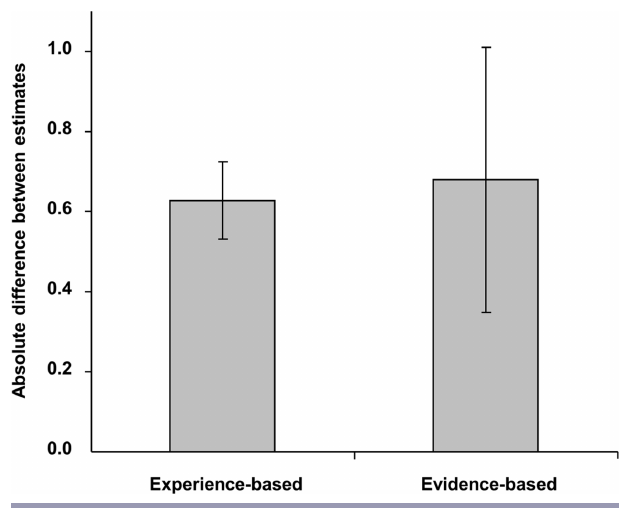
Fig. 3 . The difference between the practitioner’s (experience- based) and the BioMetric (evidence-based) estimates of vegetation condition according to the type of information available to support the latter (n = 28). Bars represent mean (± S.E.).